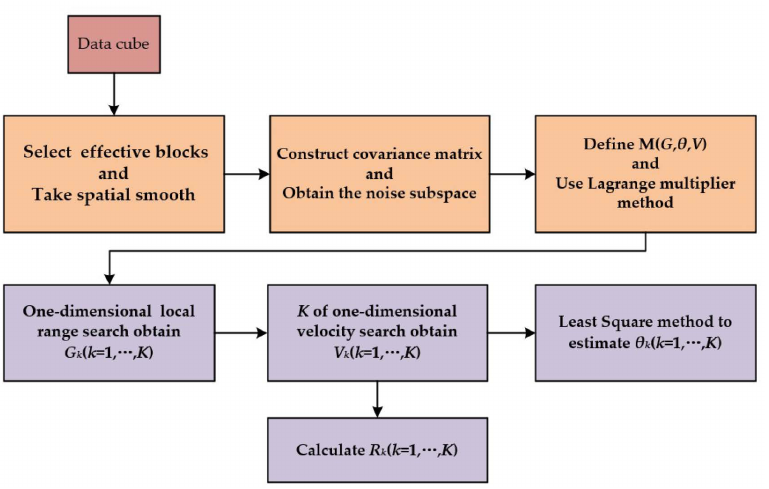
Figure 6. Flowchart of the proposed low complexity